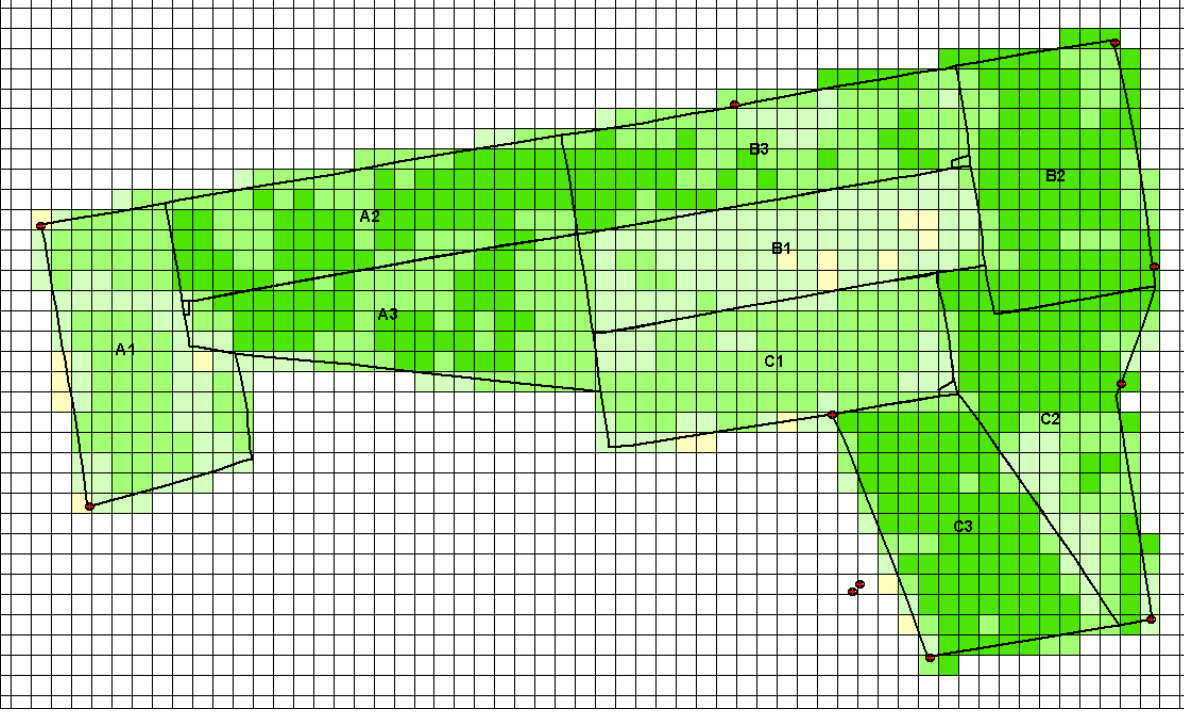
Figure 4 . RGBVI analysis of the UAV-derived orthophoto for the 10 m polygon grid (05 June